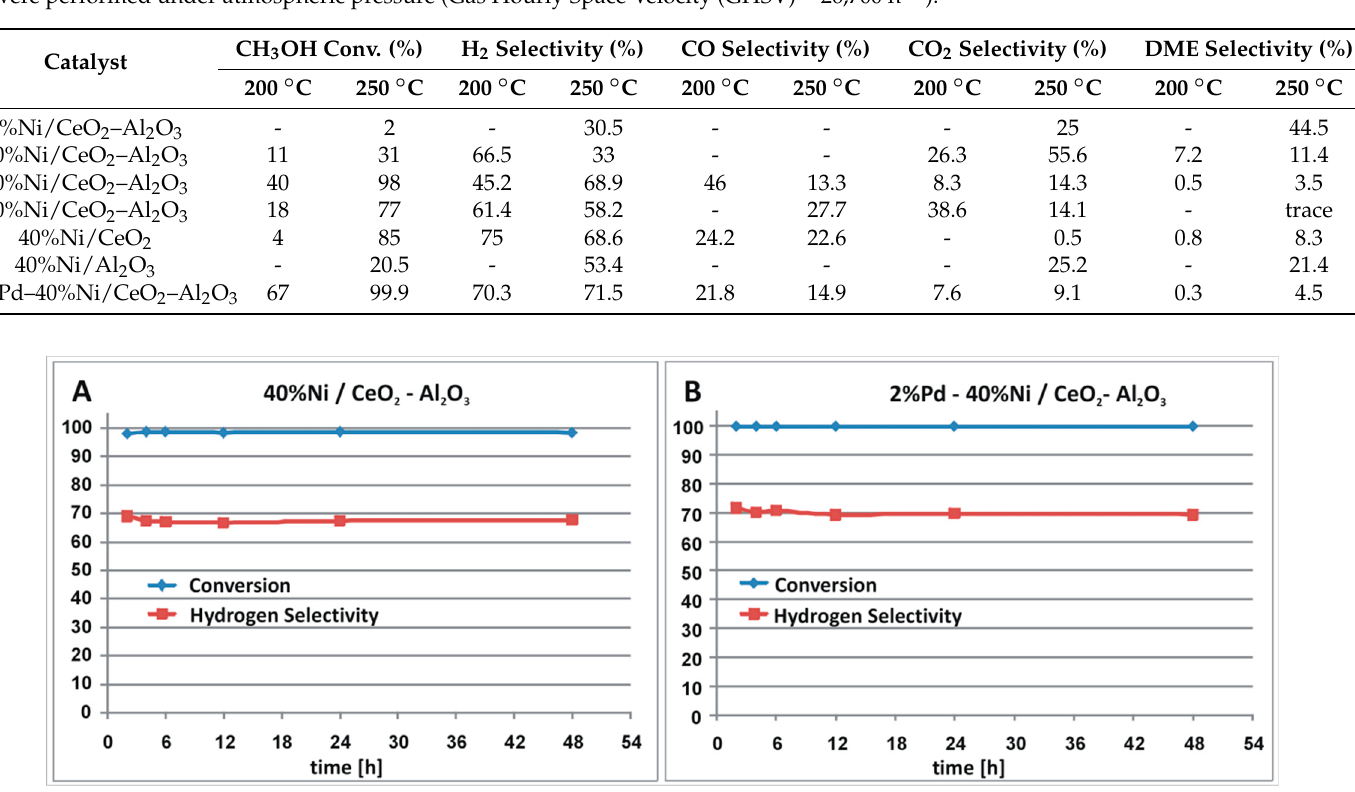
Figure 1. Methanol conversion and selectivity towards hydrogen formation for ( A ) monometallic Ni/CeO 2 –Al 2 O 3 supported catalyst; and ( B ) bimetallic Pd–Ni/CeO 2 –Al 2 O 3 during 48 h of the reaction performed at 250 ◦ C after reduction 1 h at 300 ◦ C in a mixture of 5%H 2 –95%Ar.). Reaction condition: weight of catalyst = 0.2 g, H 2 O/CH 3 OH/O 2 molar ratio in the reaction mixture = 1/1/0.4, temperature of the reaction 200 and 250 ◦ C. The catalytic tests were performed under atmospheric pressure (Gas Hourly Space Velocity (GHSV) = 26,700 h − 1